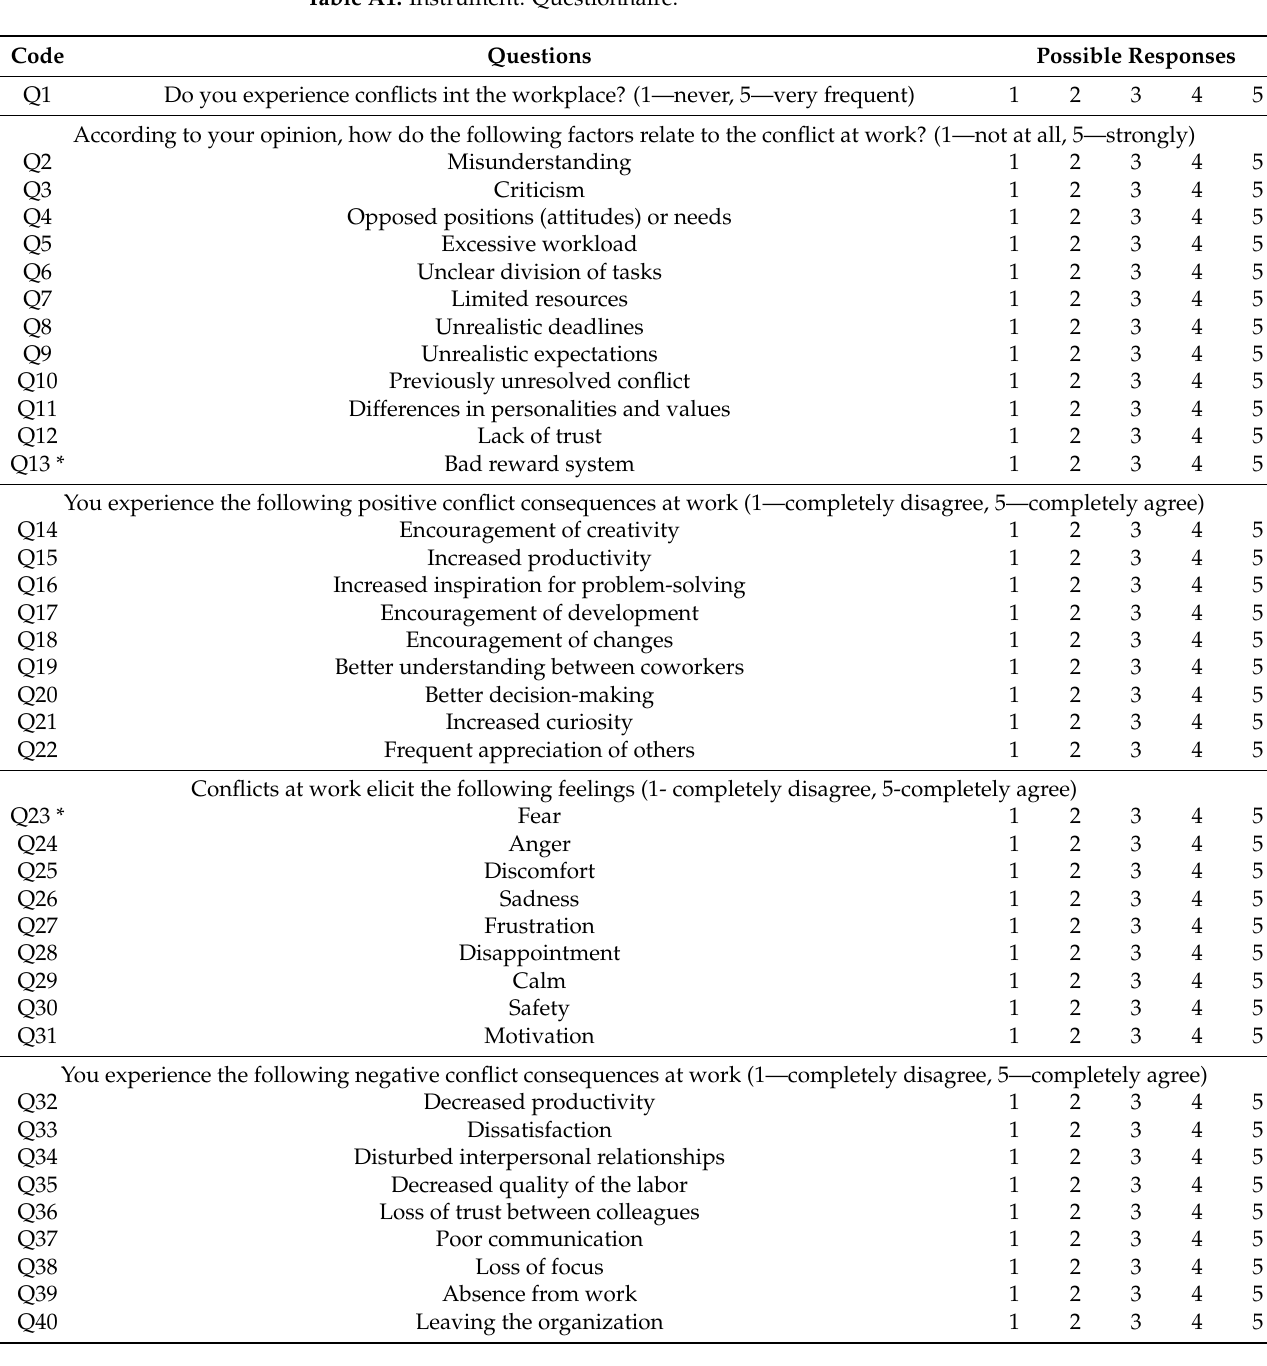
Table A1. Instrument: